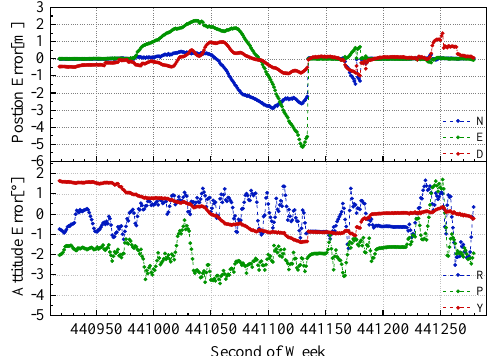
Figure 15. Position and attitude errors of the GNSS/INS integrated navigation system in the urban area test.